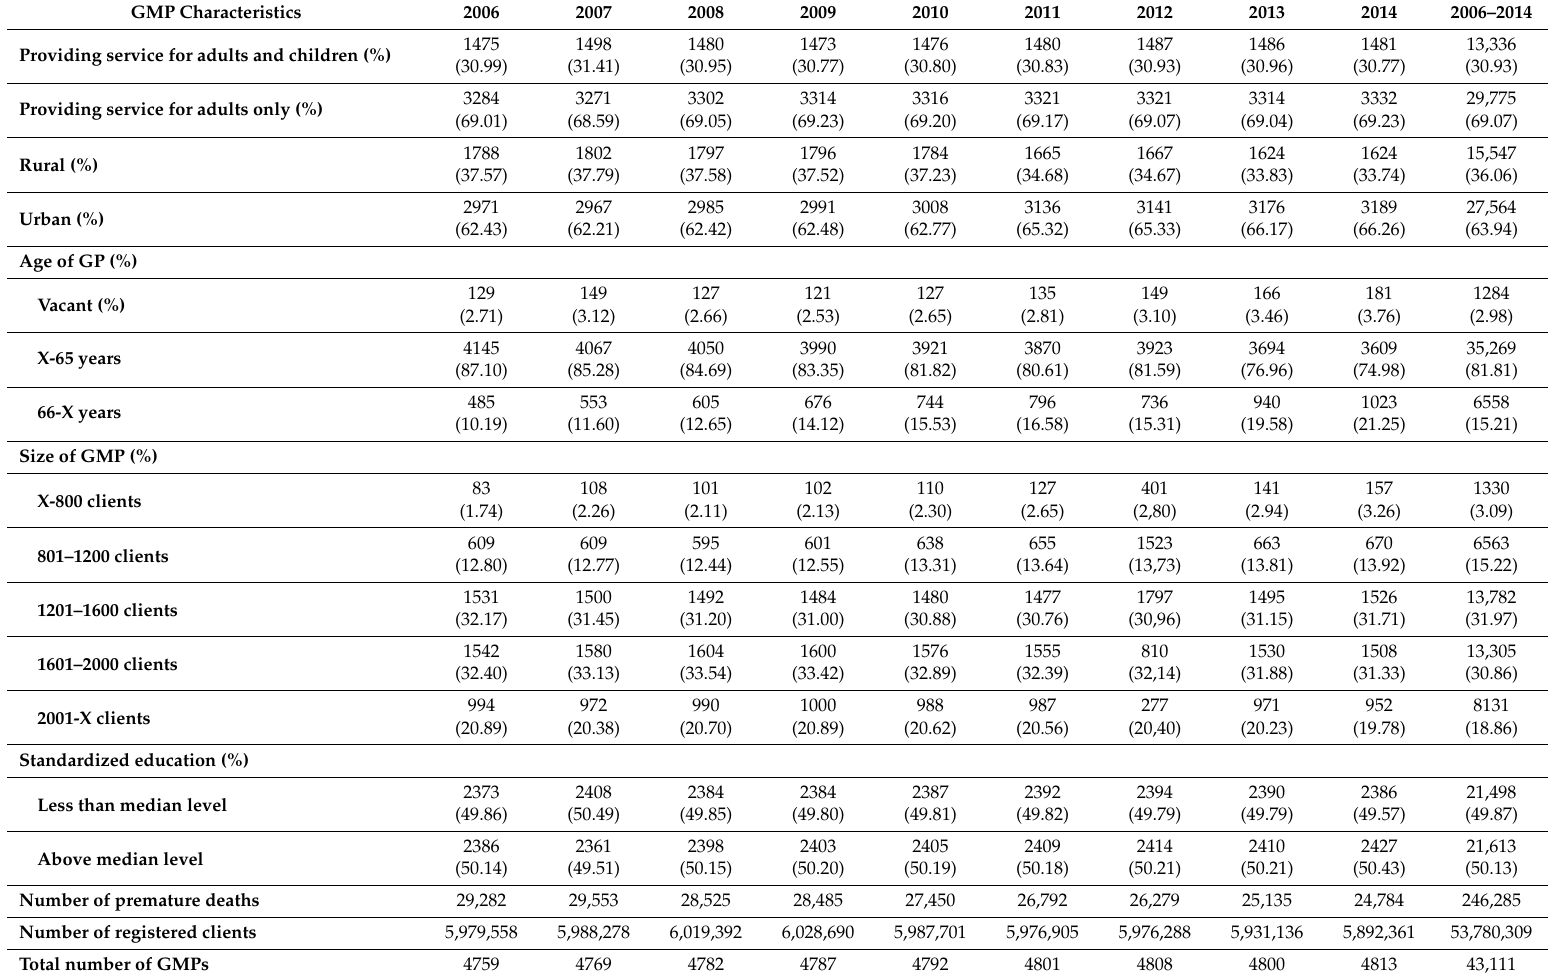
Table 1. Distribution of general medical practice (GMP) characteristics by year in Hungary during 2006–2014 according to the National Health Insurance Fund